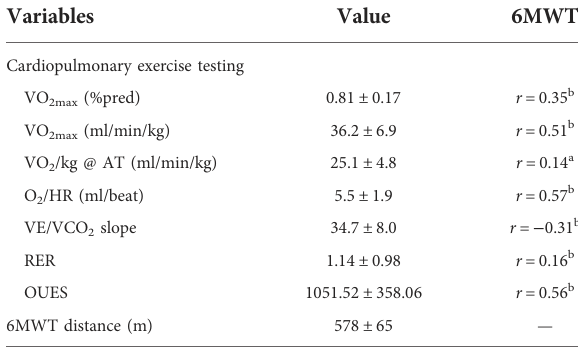
TABLE 3 Exercise performance and the relationship between peak oxygen uptake and the 6-min walk test.